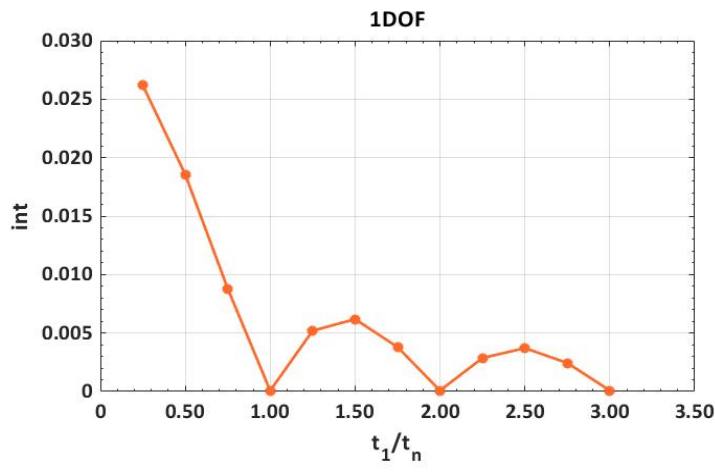
Figure 4. Cost function int with respect to the adimensional time τ for the 1DoF model.